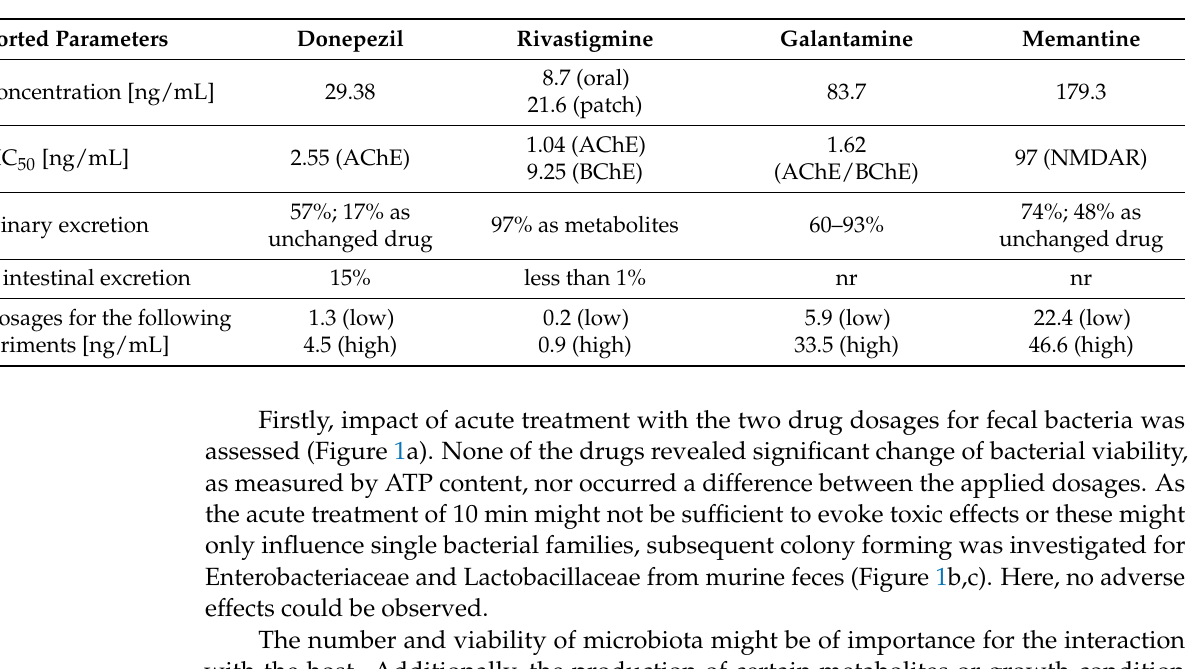
Table 2. Estimation of fecal drug concentration. Putative fecal concentrations of the four drugs were calculated by using reported fecal excretion rates. In case only urinary excretion has been investigated, remaining percentage was assumed to be excreted by the gastrointestinal tract. Available ratios of unchanged drug excretion were also taken into account to calculate minimally amounts (low). (nr: not reported; information taken from [26–28] and Novartis drug information; https://www.drugs.com/ppa). (BChE: Butyrylcholine